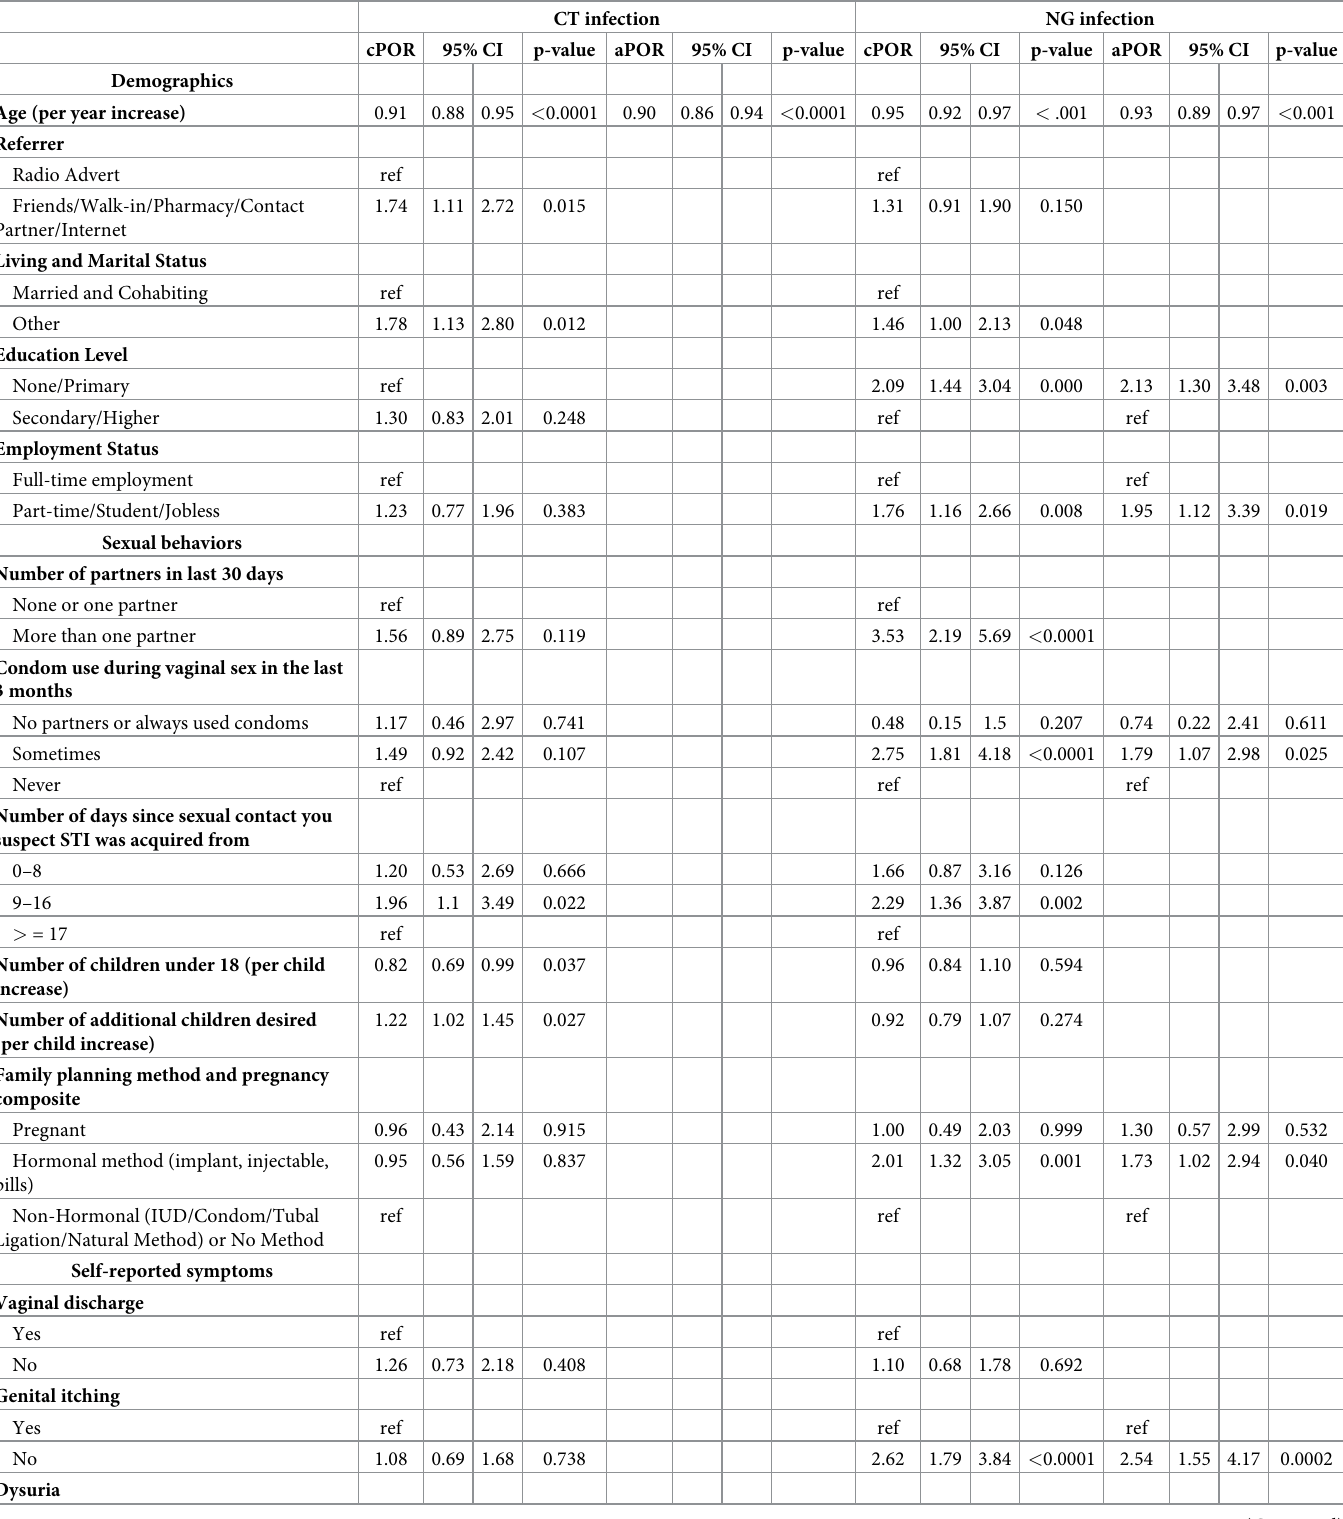
Table 5. Univariate and multivariate analysis of factors associated with CT or NG infection in women in Kigali, Rwanda (N =